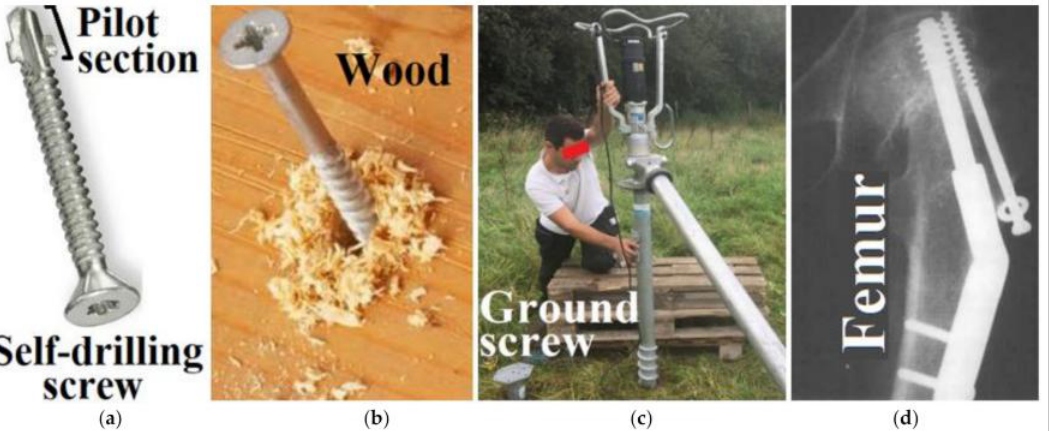
Figure 1. Common applications and design of engineering screw